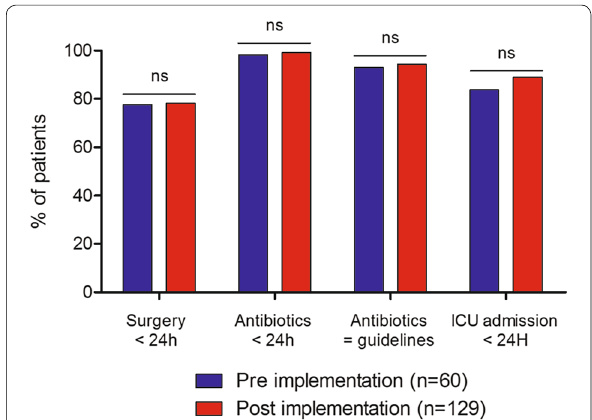
Fig. 3 Impact of the implementation of a multimodal bundle of care on pre‑defined patient management outcomes. Patients from the pre‑ (blue histograms) and post‑implementation (red histograms) periods are compared. None of the comparisons yielded statistically different results by Fisher’s exact test or the Chi‑squared test according to sample